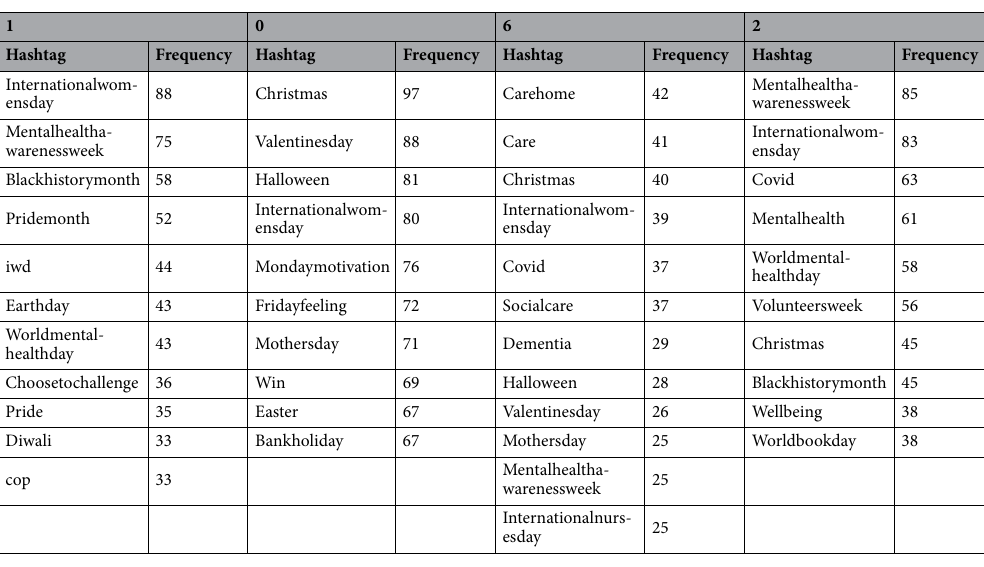
Table 5. Frequency of top 10 hashtags in the subcommunities with more than 50 nodes in Orange-red community, 1/2.